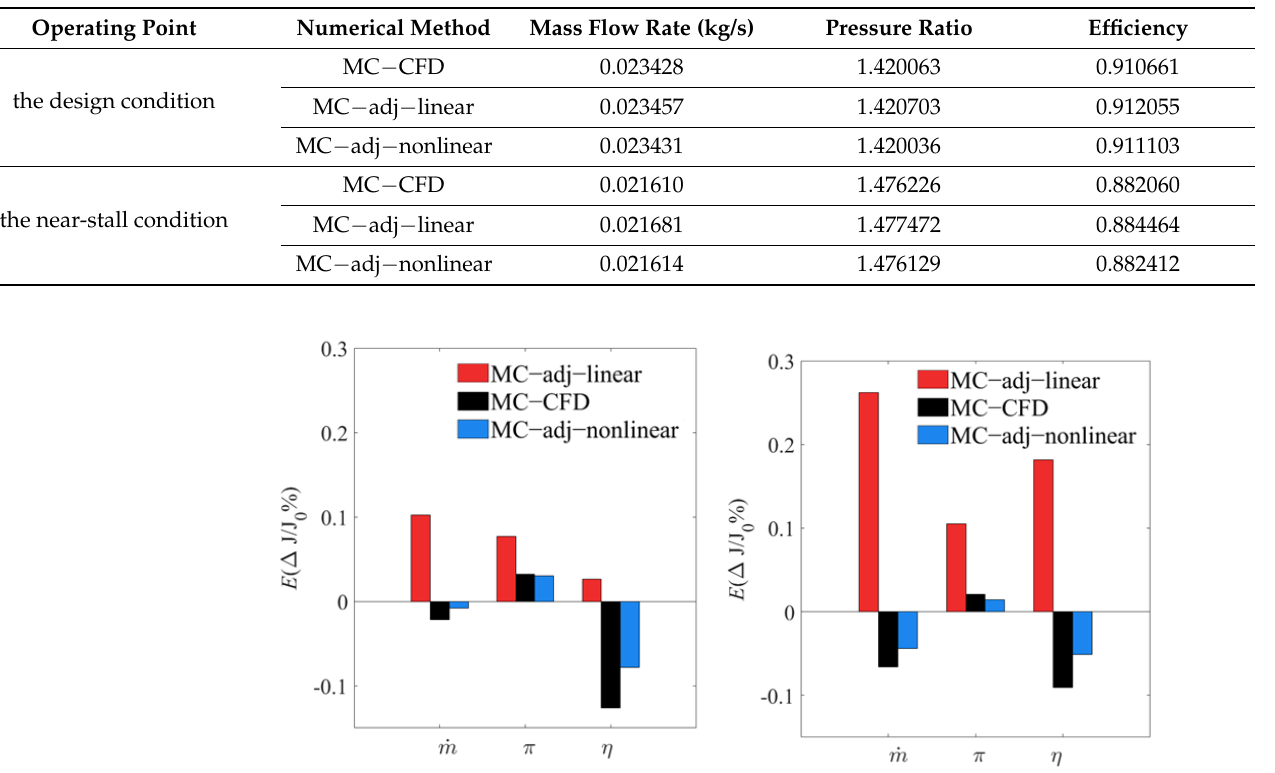
Figure 11. The mean of normalized performance variations at the design ( left ) and near-stall condi- tions ( right ) computed using the three